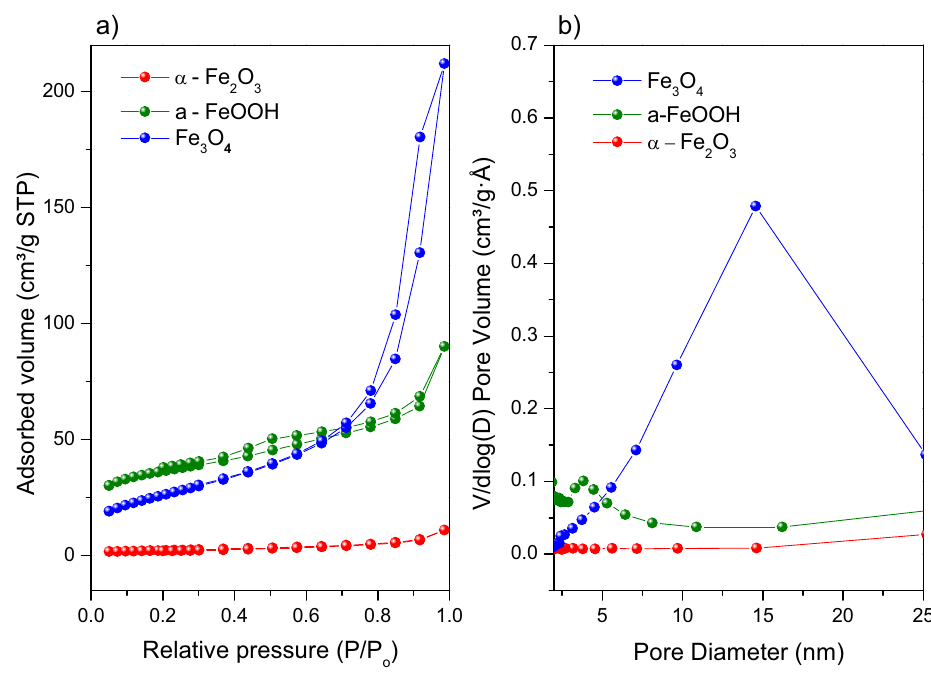
Figure 4: ( a ) Adsorption and desorption isotherms for the synthesized iron oxides and ( b ) pore diameter distribution according to the BJH model for synthesized iron